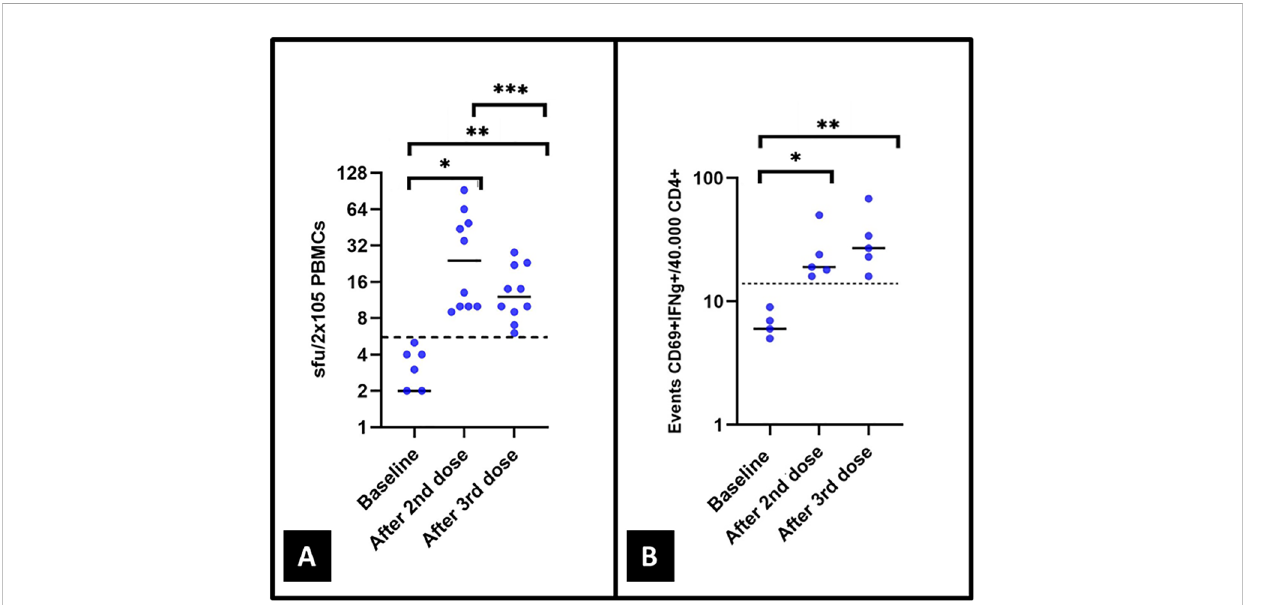
FIGURE 3 The T-cell response was measured in 10 and 5 patients by (A) ELISpot and (B) CoVITEST, respectively, both at baseline and after the second and third vaccine doses. In (A) , p values of 0.02*, 0.007**, and 0.044***. Four patients with 0 spots at baseline are not included in (A) . In (B) , p values of 0.042* and